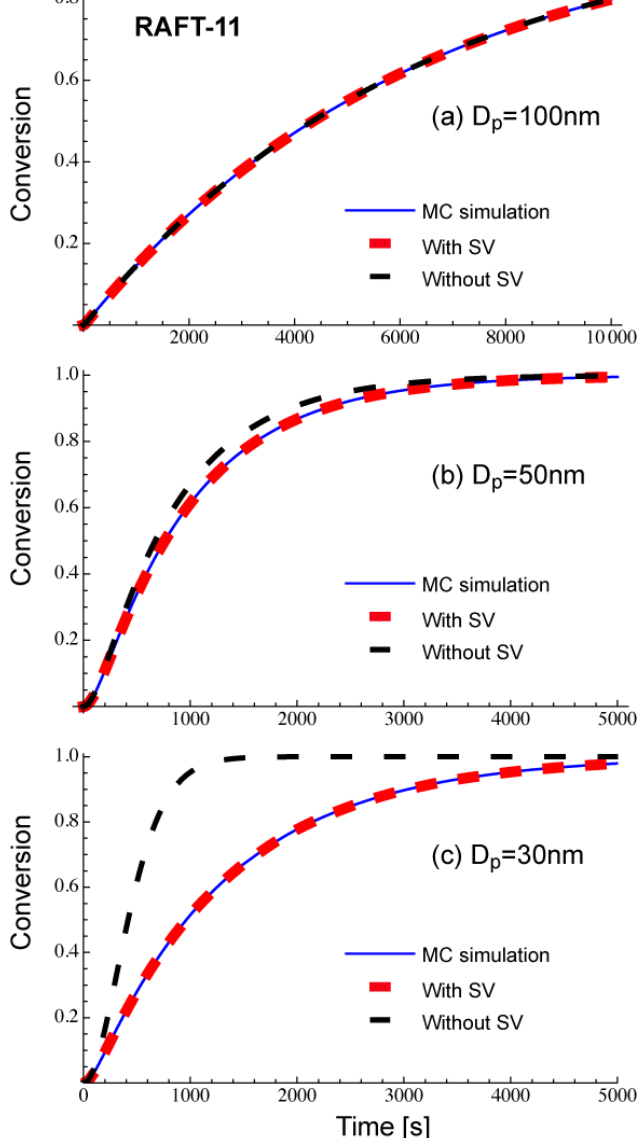
Figure 4. Calculated conversion development for a miniemulsion RAFT polymerization, whose parameters are shown in Table 2, named as RAFT-11. The blue line is obtained from the Monte Carlo simulation; the red symbols are calculated from Equation (11) that accounts for the statistical variation of concentrations among particles; and the black symbols are from Equation (12) that neglects the statistical